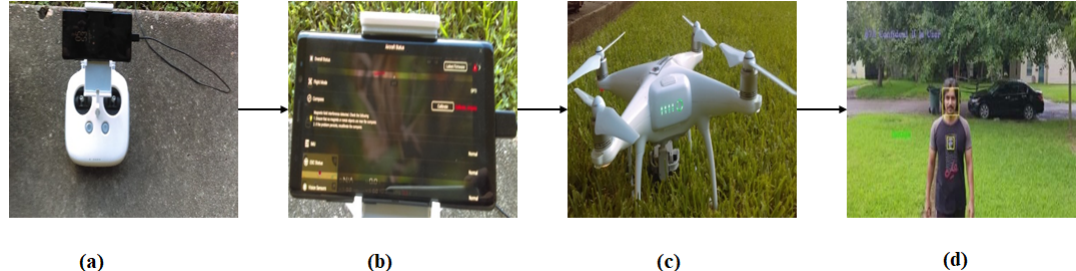
Figure 8. DJI GO App ( a ) Connected to mobile device ( b ) assembling with the aircraft ( c ) aircraft warming ( d ) recognized face in rainy weather.